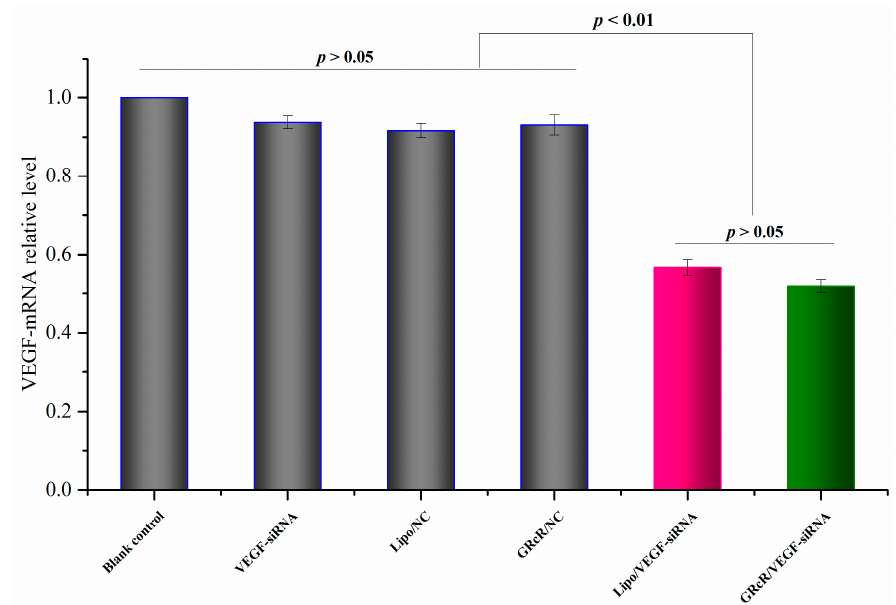
Figure 13. VEGF mRNA levels of the HeLa cells treated with naked VEGF-siRNA ,